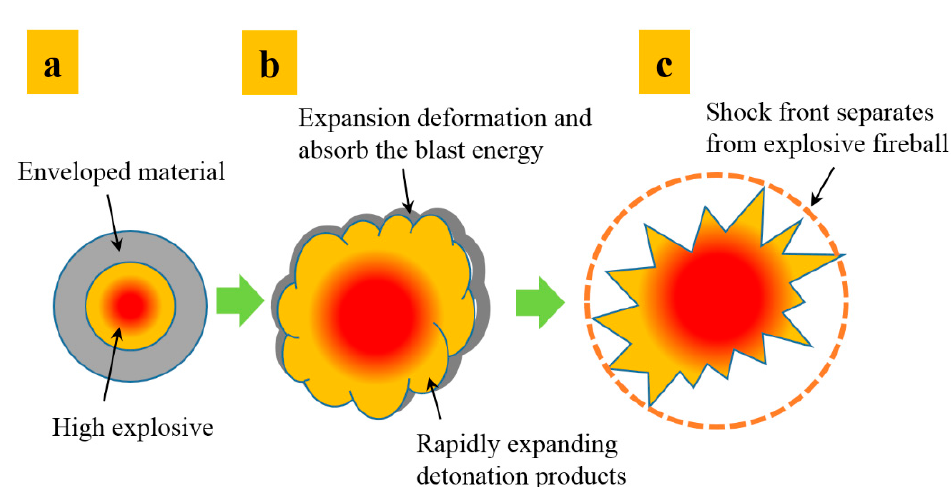
Figure 2. Explosion mechanism of charge enveloped by polymer matrix composite shell (( a – c ) stages represent the detonation reaction of the inner charge, the mixing and expansion of the detonation products and cladding, the formation of the blast shock wave respectively).